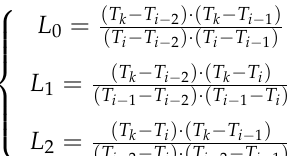
Figure 4. Scale factor varies with temperature. -50